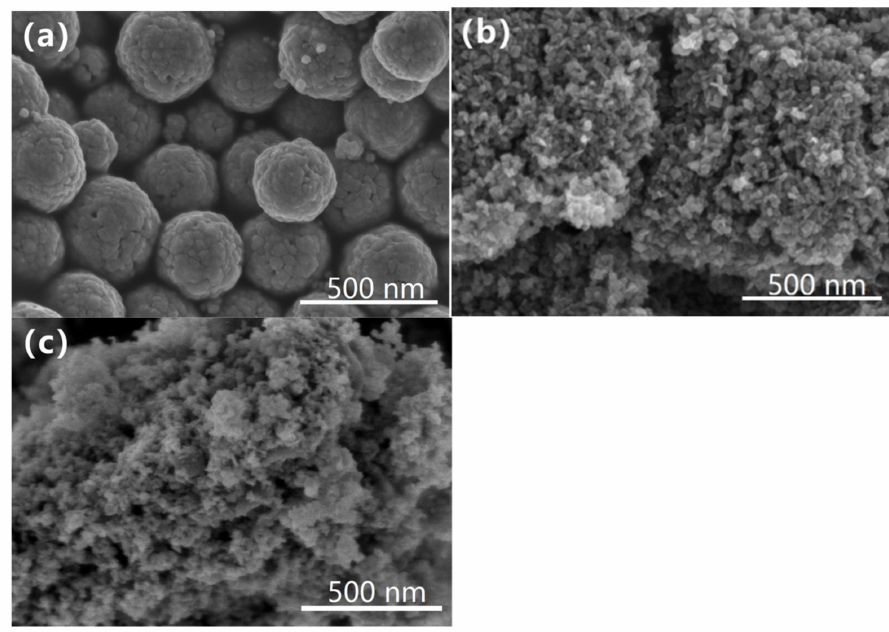
Figure 3. FESEM images. ( a ) Fe 3 O 4 ; ( b ) TiO 2 ; ( c ) Fe 3 O 4 @TiO 2